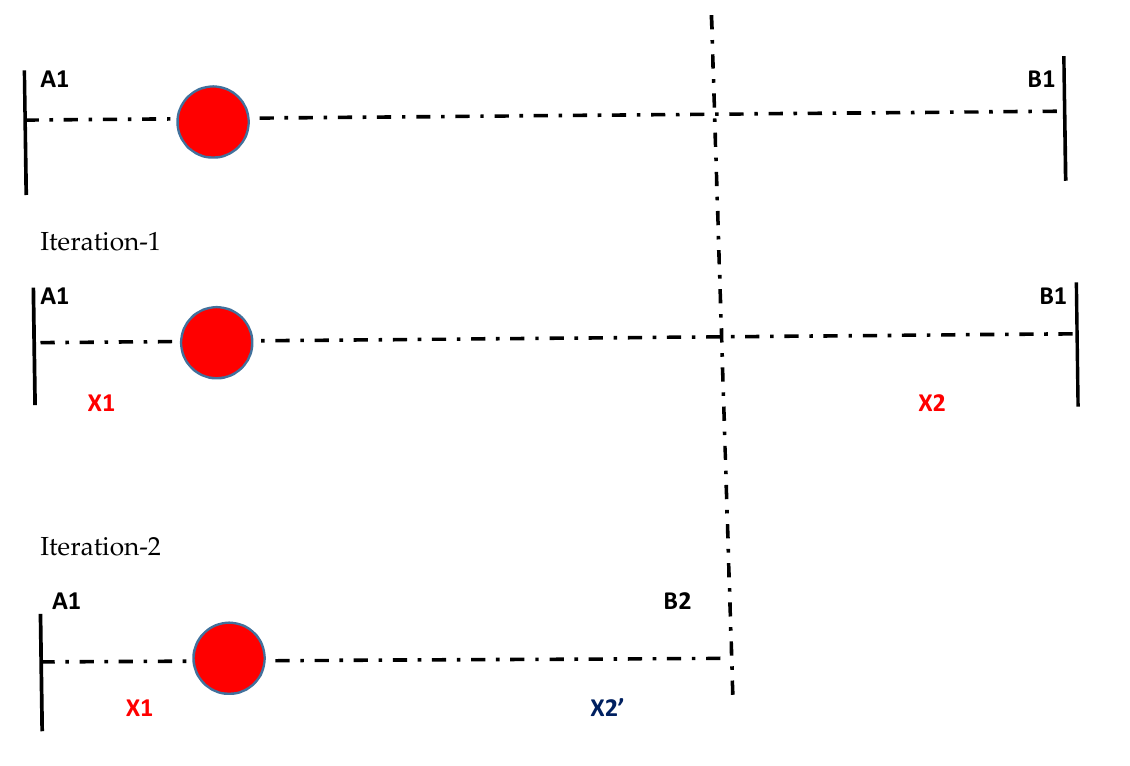
Figure 2. Solving the one-dimensional problem by recursive halving the search